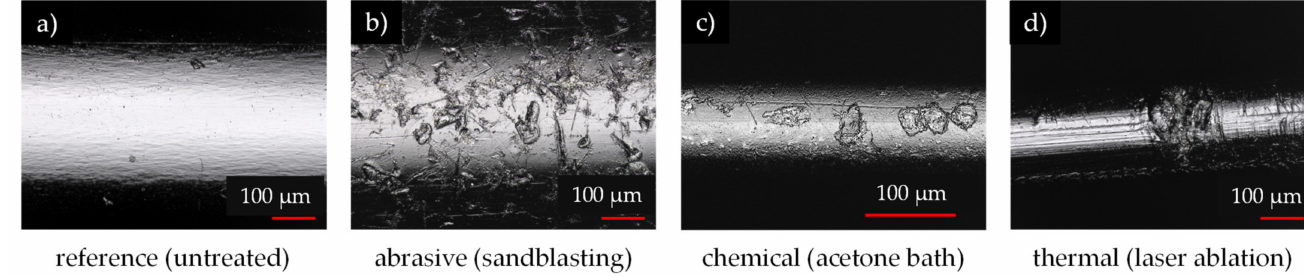
Figure 6. Images of differently treated POF surfaces using laser confocal microscopy ( a ) untreated reference POF surface, ( b ) particle-blasted POF surface, ( c ) POF surface after acetone bath, and ( d ) laser-treated POF surface, reproduced with permission from the Welding and Joining Institute of RWTH Aachen University, Aachen,